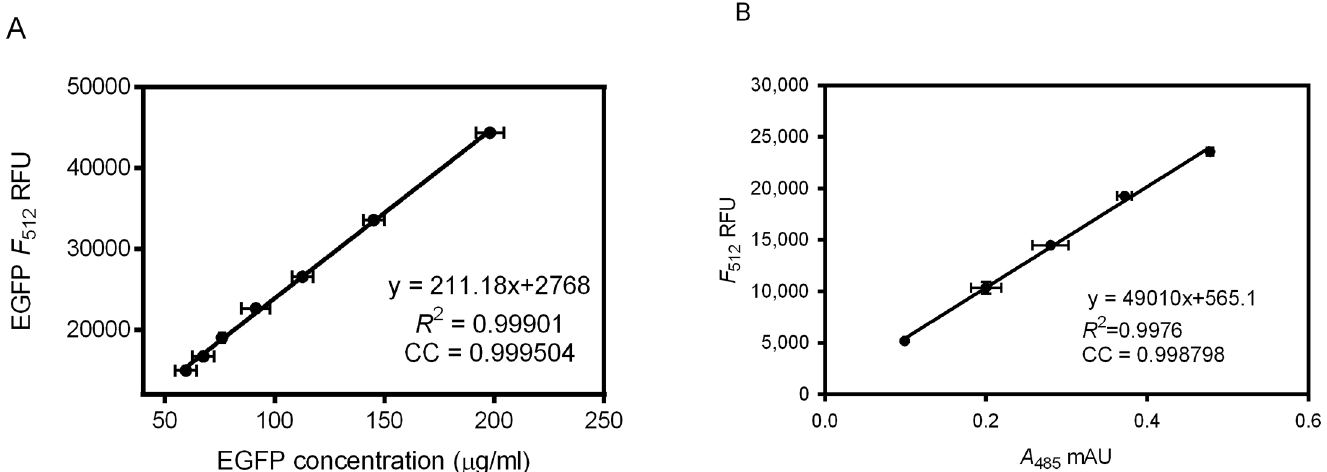
λ ex = 485nm, em = 512 nm) against EGFP-His6 concentration (mg/ml) determined by BCA assay. (B) A plot of purified ASBT NM - EGFP-His8 fluorescence emission ( λ ex = 485 nm, λ em = 512 nm) against absorption at 485 nm. Each data point represents 0.1 mg ml -1 and 2-fold serial diluted ASBT NM -EGFP-His8 (from high to low concentrated). Vertical and horizontal error bars represent the standard error of the mean (n = 3) from three independent measurements.